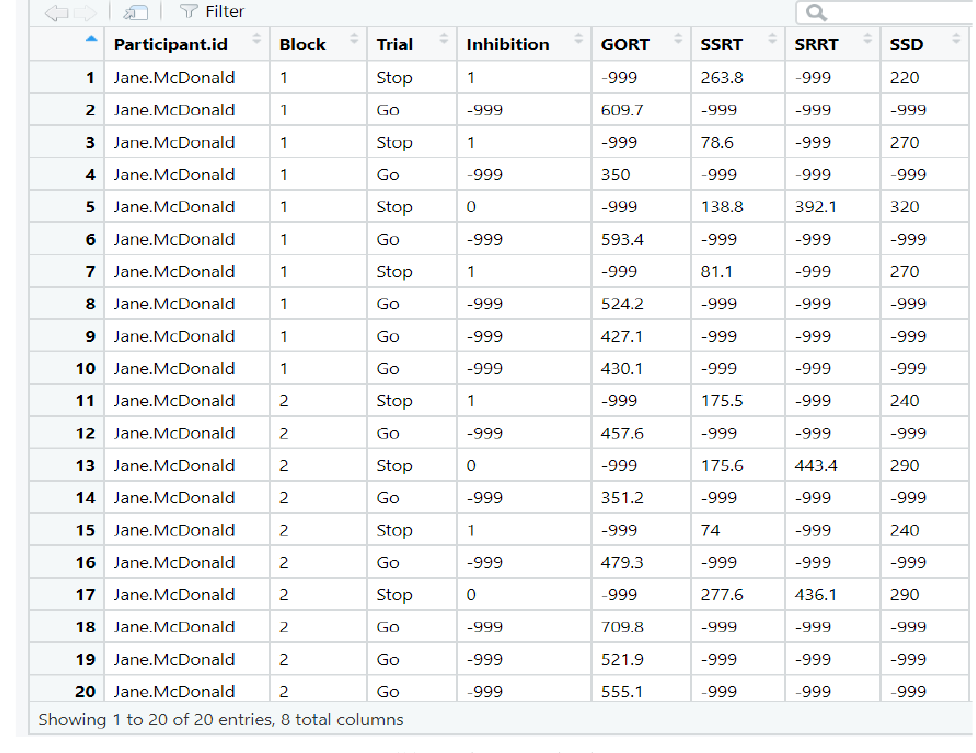
Figure 3. Sample SimSST R software package(R studio version 4.1.3) simulated SST data output with input variables as in the